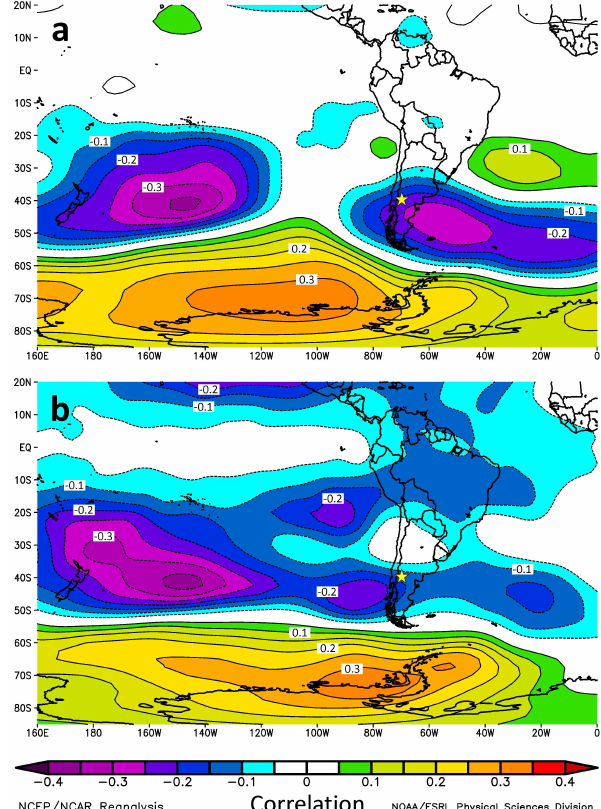
Fig. 9. Spatial correlation patterns during the interval 1948–2000 between October–June 500HPa geopotential height anomalies and (a) instrumental and (b) reconstructed October–June Neuqu´en River streamflow. The yellow stars indicate the location of Paso de Indios gauging station. Solid and dashed contours indicate positive and negative correlations, respectively; zero contours are omitted. Correlation analyses and gridded geopotential height data were ob- tained from the National Oceanic and Atmopheric Administration website (http://www.esrl.noaa.gov/psd/data/correlation/).